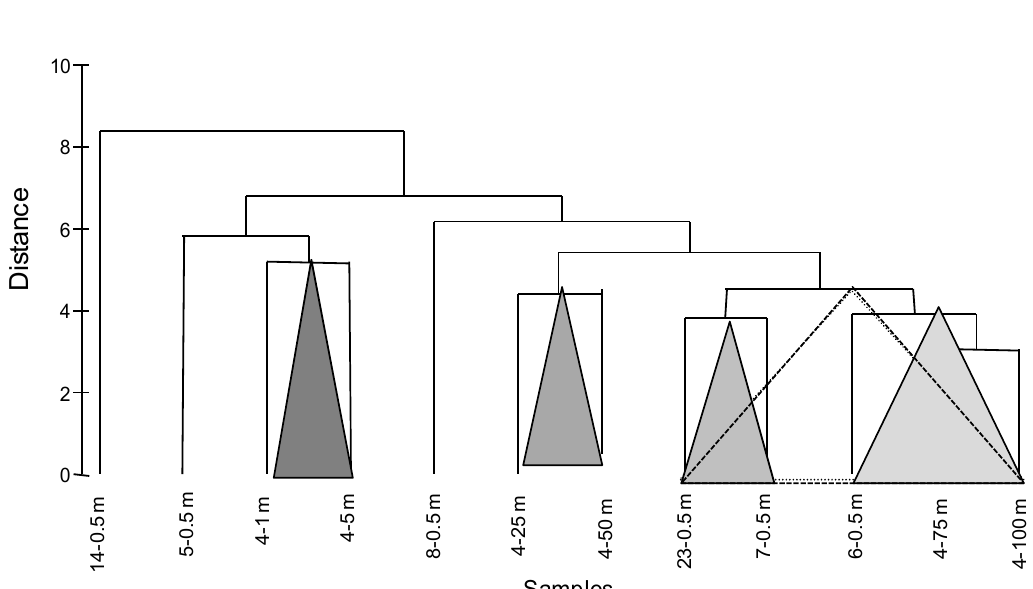
Figure 9. Dendrogram obtained by the cluster analysis of environmental and microbiological data. The main sub-clusters identified according to the Euclidean distance values were indicated by the triangles.